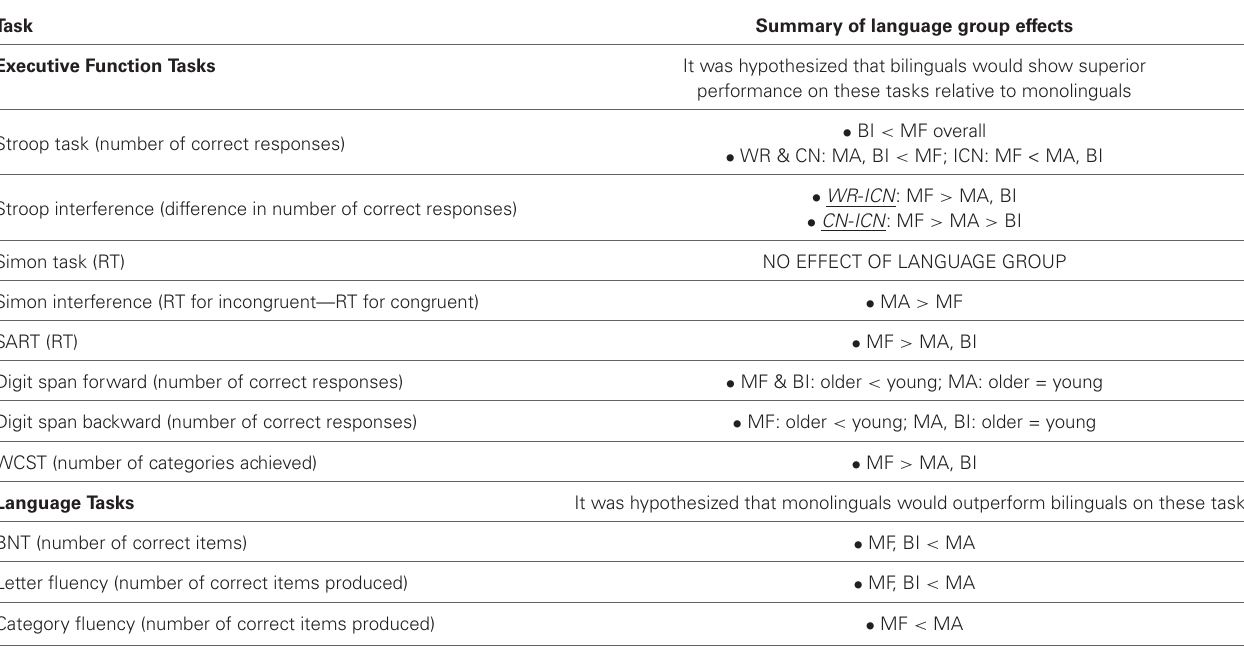
Table 4 | Summary of language group (and language group by age interaction) effects by task